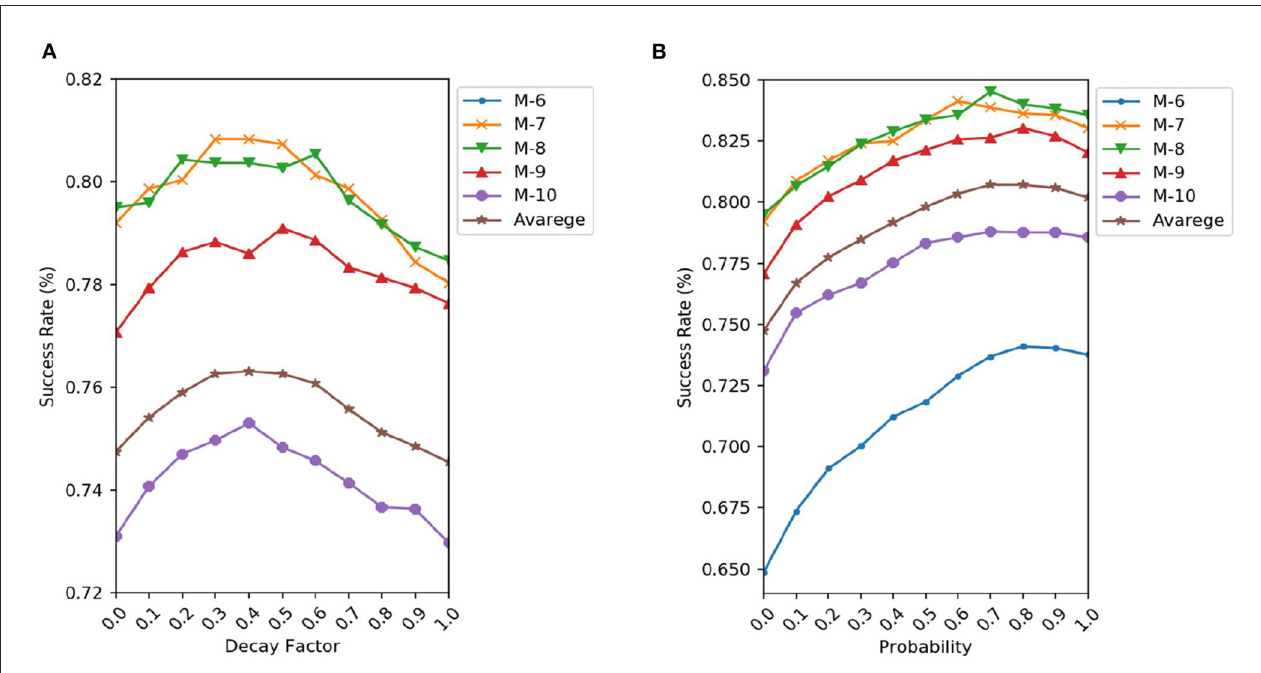
FIGURE3 Success rate of RGEA-MI-FGSM (A) and RGEA-DI-FGSM (B) when the corresponding parameters are